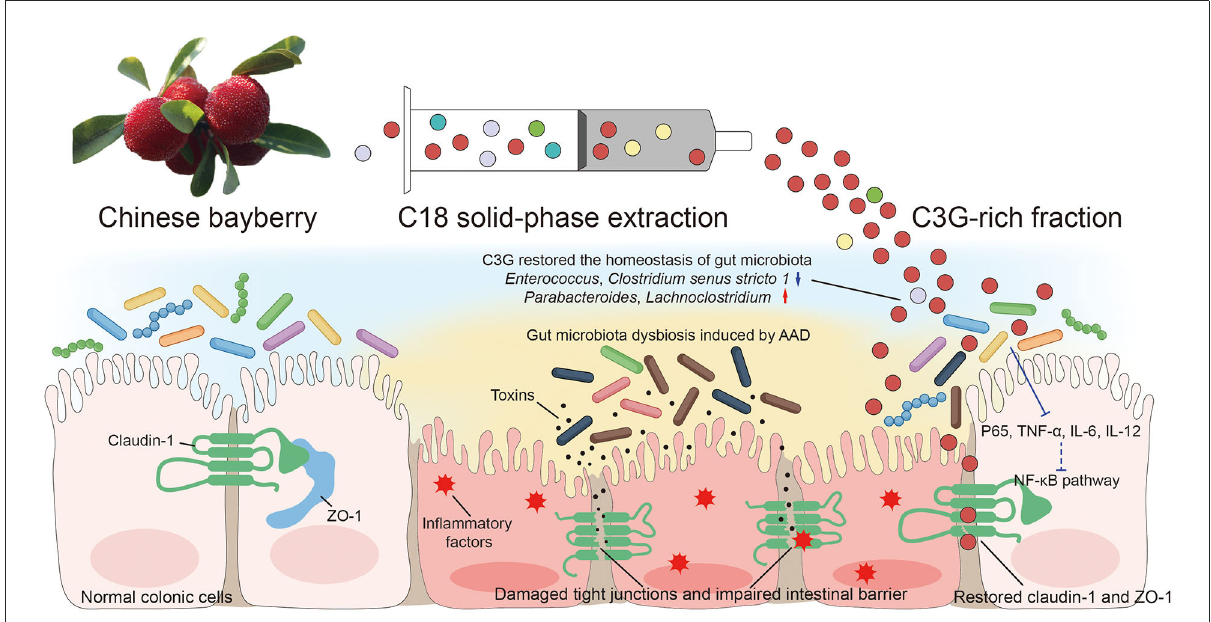
FIGURE8 Schematic diagram showing the possible mechanisms of alleviating AAD effects of Chinese